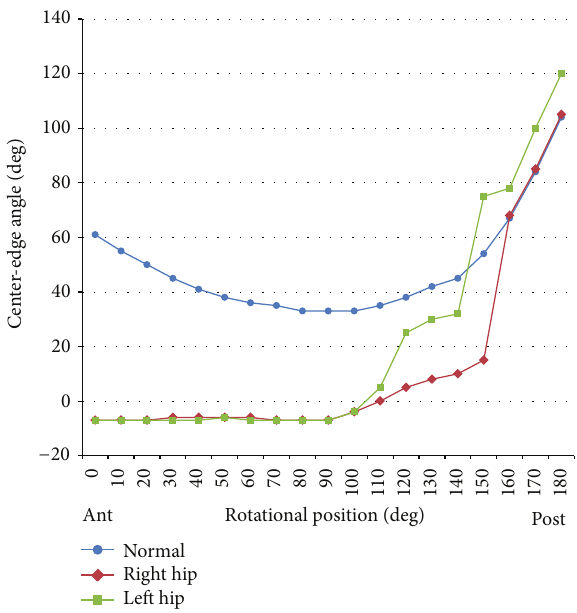
Figure 4: Comparative plots of the center-edge angle (CEA) measured by a transverse CT slice through the center of the femoral head for the bilateral hip joints versus mean normal values reported by Janzen et al. Our case showed very narrow acetabular coverage from the anterior to lateral area of the femoral